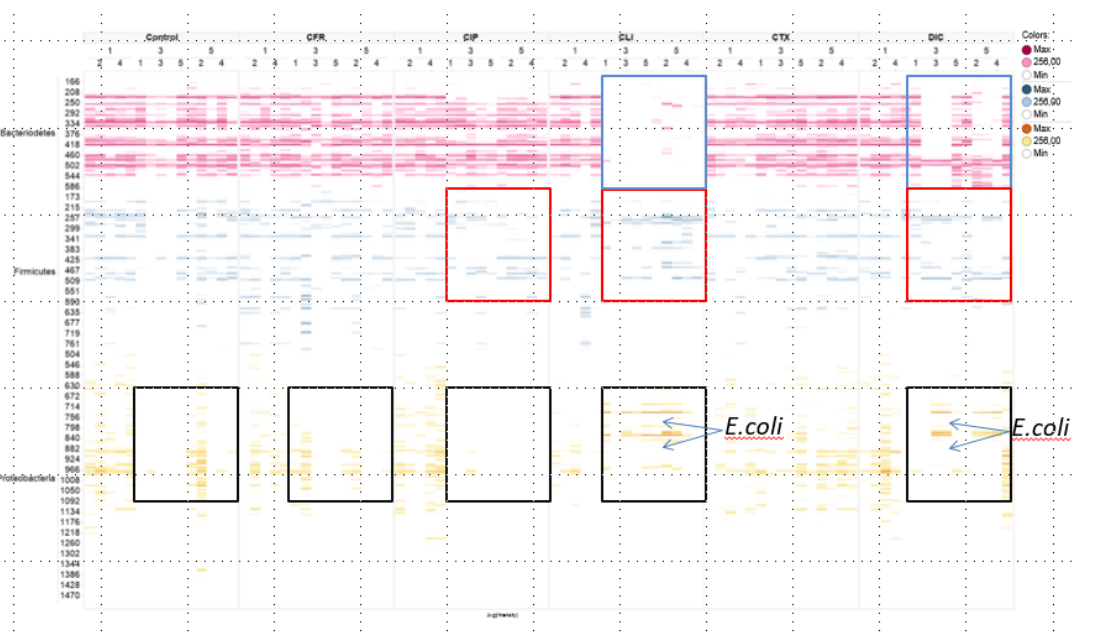
Figure 1. Bacterial phylum profiles per mouse and antibiotic group (five mice per antibiotic or control), established by 16S rRNA analyses. Colour intensity of the bands indicates quantities of respective species. Each band represents a microbial interspace (ITS) fragment, corresponding to an operational taxonomy unit (OTU). Fragments are sorted into their corresponding phylum. No bands; indicate the absence of bacterial species. “1” = Day 1, “3” = Day 3, and “5” = Day 5. Numbers below indicate that data are shown for each individual mouse. Five mice in two different cages. Blue boxes indicate the shift in Bacteroidetes composition for clindamycin and dicloxacillin. Red boxes indicate the shift in Firmicutes composition for ciprofloxacin, clindamycin, and dicloxacillin. Black boxes show depletion of Proteobacteria in most antibiotics groups (and in controls). We have indicated the concurrent invasion of E. coli in clindamycin and dicloxacillin treated mice. Control : No antibiotics given; CFR : Cefuroxime; CIP : Ciprofloxacin; CLI : Clindamycin; CTX : Cefotaxime; DIC : Dicloxacillin.